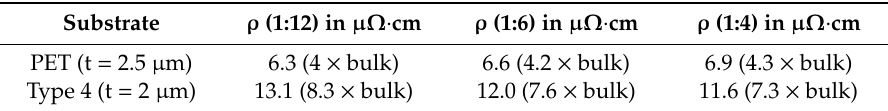
Table 5. Resistivity values ρ of the Ag-layers on PET and the type 4 paper substrate for di ff erent line length to width ratios.